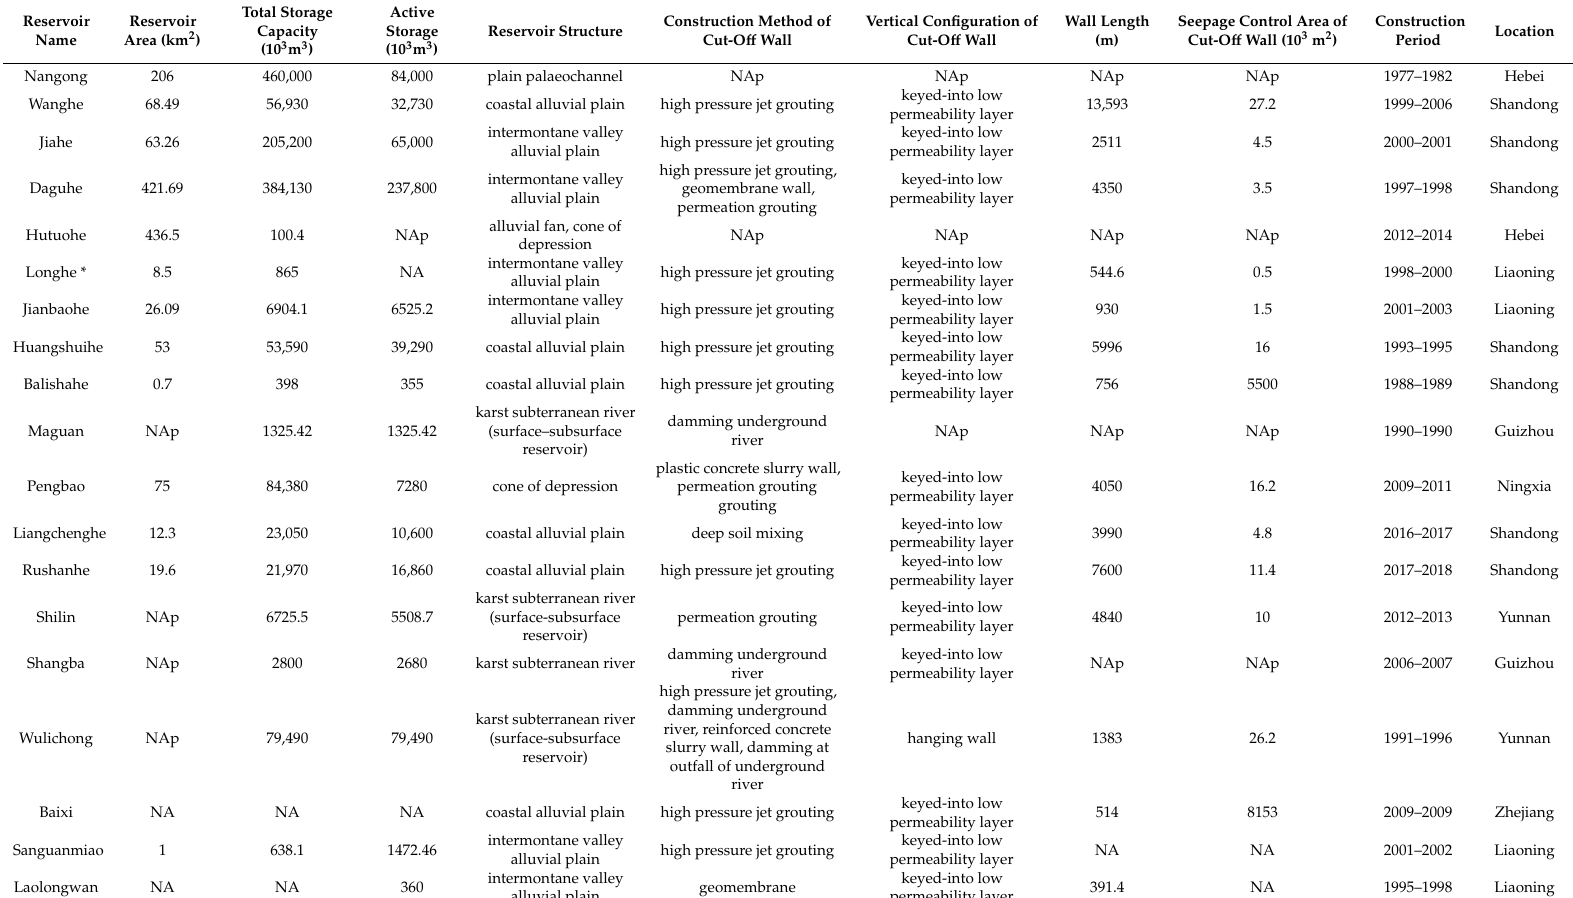
Table A1. Basic information of some artificial underground reservoirs in